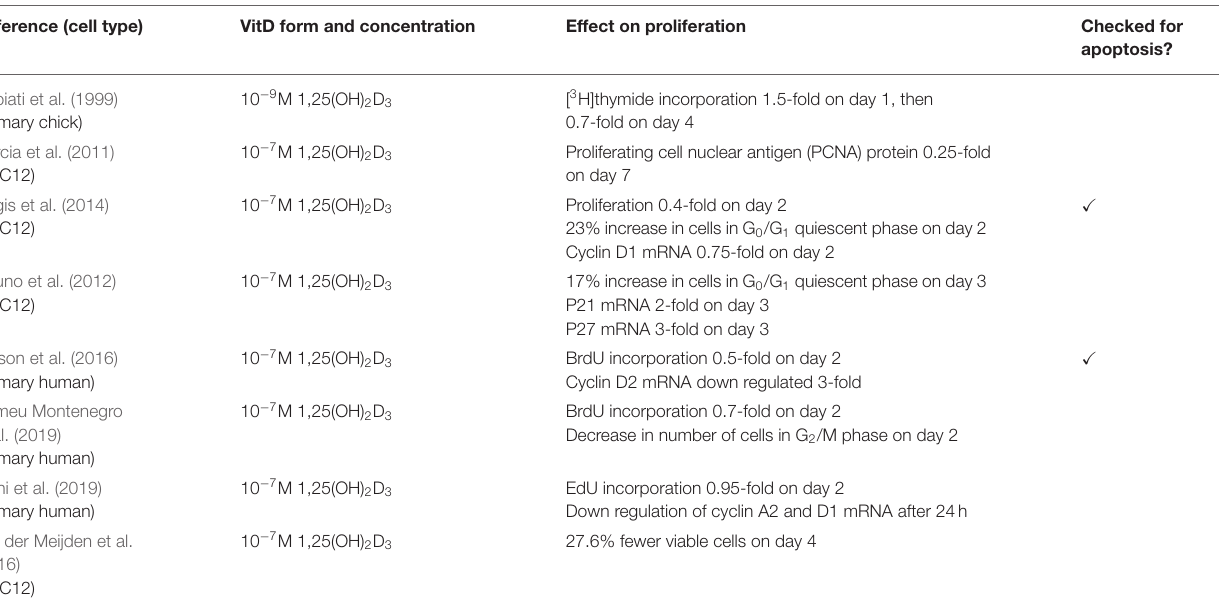
TABLE 3 | Effects of 1,25(OH) 2 D 3 on